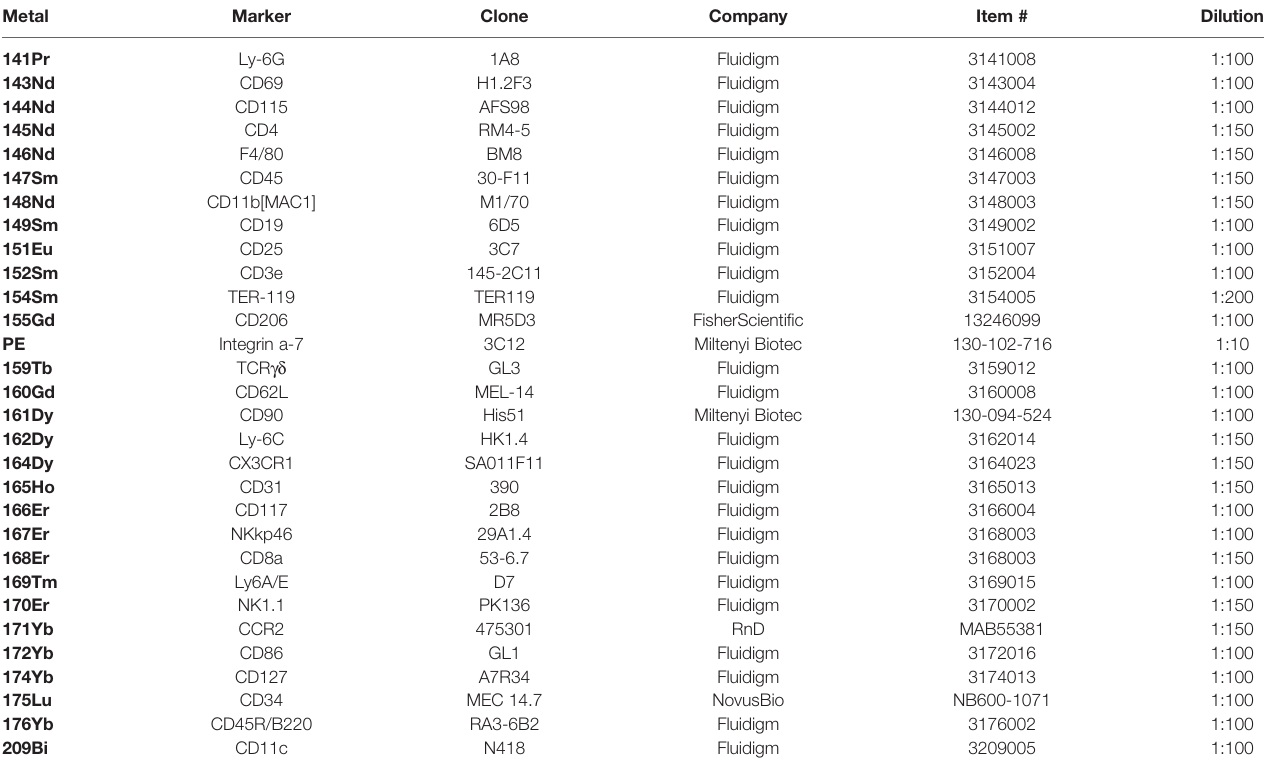
TABLE 1 | List containing all antibodies utilized for surface staining of mass cytometry samples. Metal Marker